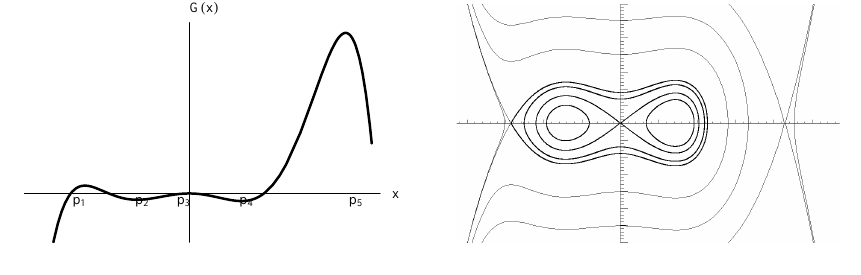
Figure 3. The primitive G ( x ) . Figure 4. The phase plane for the case G ( p 3 ) < G ( p 1 ) < G ( p 5 )